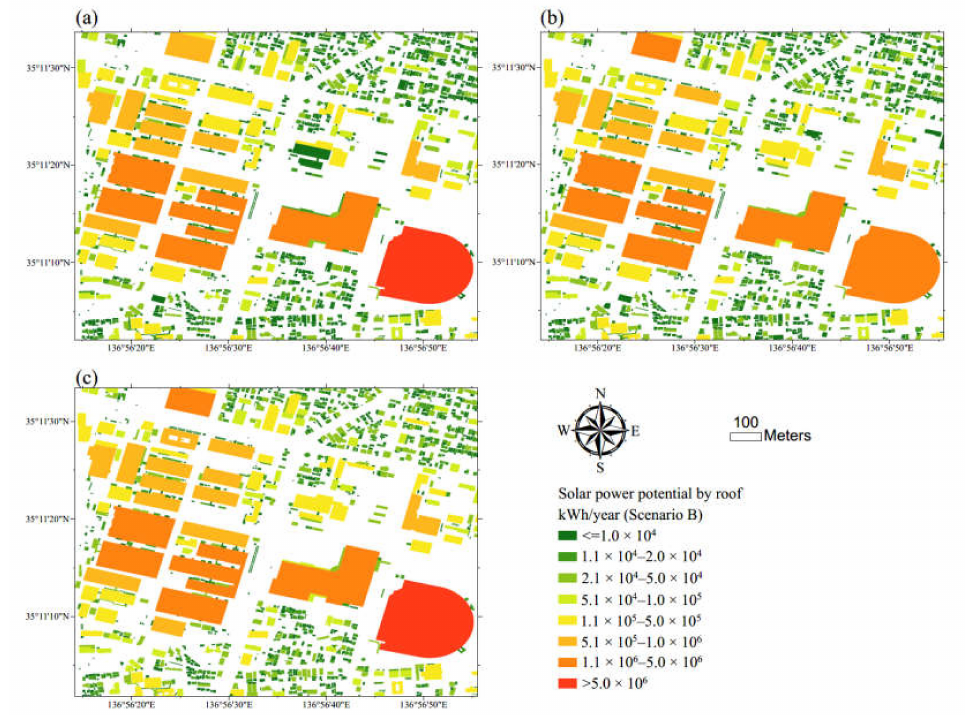
Remote Sens. 2022 , 14 , x FOR PEER REVIEW Figure 6. The electricity generation potential of solar photovoltaic (PV) estimated by three methods in a part of western Aichi (Scenario B): ( a ) Method 1 ( b ) Method 2 ( c ) Method 3.